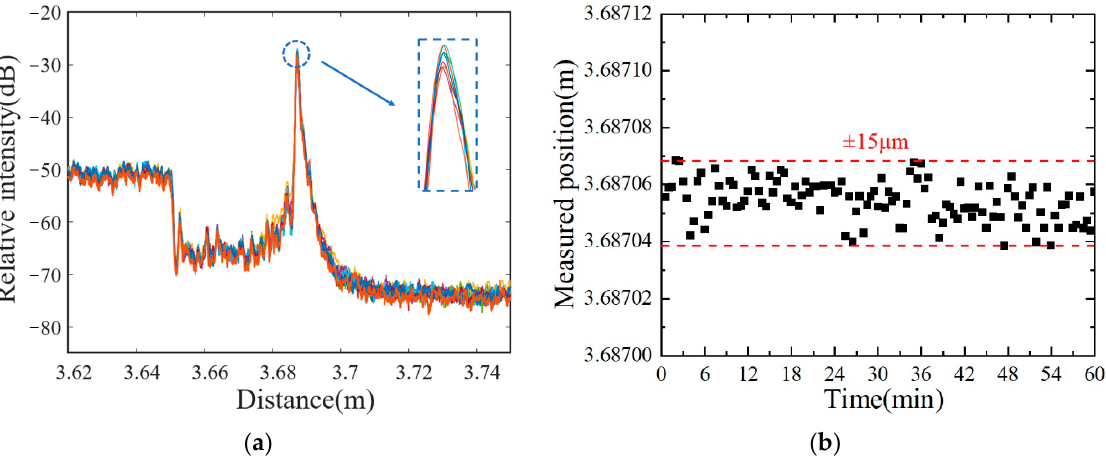
Figure 11. Stability experiment of the liquid-level sensor. ( a ) Typical reflection signals in the distance domain; ( b ) reflection positions collected every 30 s for 60 min.